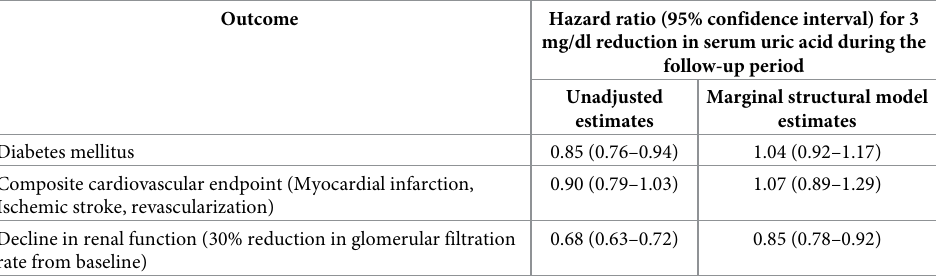
Table 3. Association between cumulative changes in serum uric acid over time and outcome events of interest in gout patients, Clinformatics ™ Datamart